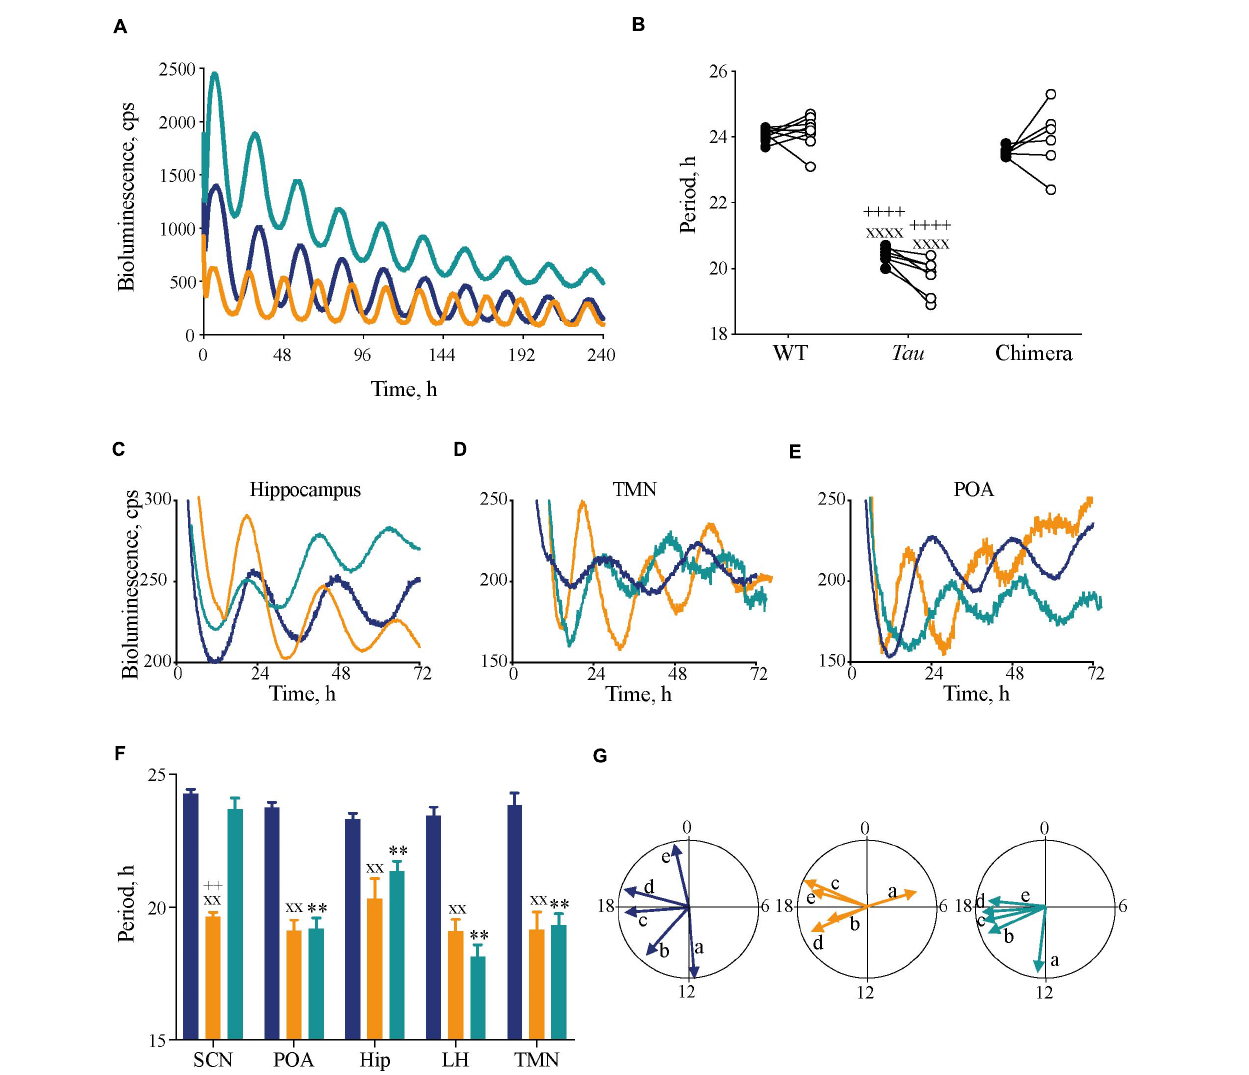
FIGURE 2 | Impact of circadian chimerism on expression of bioluminescence rhythms of PER2::Luc in SCN and extra-SCN tissues. (A) Representative PER2::Luc bioluminescence traces from ex vivo SCN slices from WT (blue), Tau (orange), and chimeric (green) mice. (B) Individual circadian periods for wheel-running in DD (closed circles) and PER2::Luc-reported SCN bioluminescence rhythms (open circles) ( n = 6–9). Note the effect of genotype within, but not between, in vivo and ex vivo measures (1xANOVA post hoc Tukey’s multiple comparisons test xxxx p < 0.0001 Tau vs. WT, ++++ p < 0.0001 Tau vs. chimera). (C–E) Representative traces of PER2::Luc bioluminescence rhythms from ex vivo hippocampus (C) , tuberomammilary nucleus (TMN) (D) , and preoptic area (POA) (E) tissue slices from WT (blue), Tau (orange), and chimeric (green) mice. (F) Mean ( ± SEM) period ( n = 5–9) of ex vivo tissue slices from WT (blue), Tau (orange), and chimeric (green) mice. All tissues, except SCN, from chimeric mice have a Tau -characteristic period of ca. 20 h (two-way ANOVA post hoc Tukey’s multiple comparisons test; ∗∗ p < 0.01 WT vs. chimera, xx p < 0.01 Tau vs. WT, ++ p < 0.0001 Tau vs. chimera). (G) Rayleigh plots of the mean vector for all tissue explants from WT (blue), Tau (orange), and chimeric (green) mice (see also Table 1 ). Note the phase-clustering in both Tau and chimeric, but not WT tissues (Rayleigh test). [a = SCN; b = Preoptic area; c = Hippocampus (Hip); d = tuberomammilary area; e = lateral hypothalamus